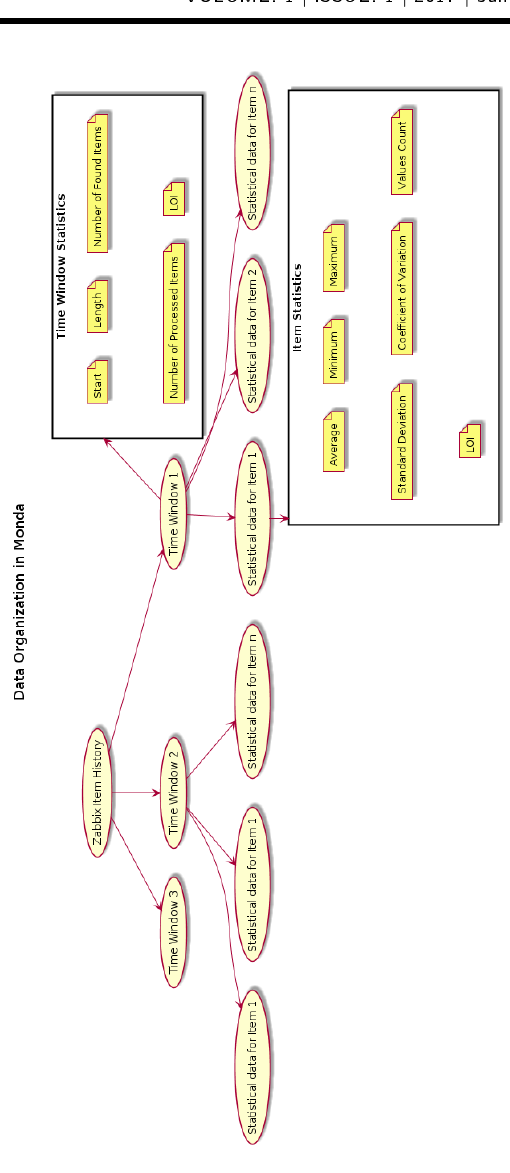
Fig. 1: Organization of data in